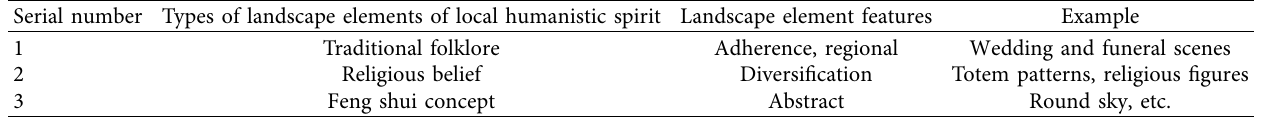
Table 5: Landscape elements of local humanistic spirit.